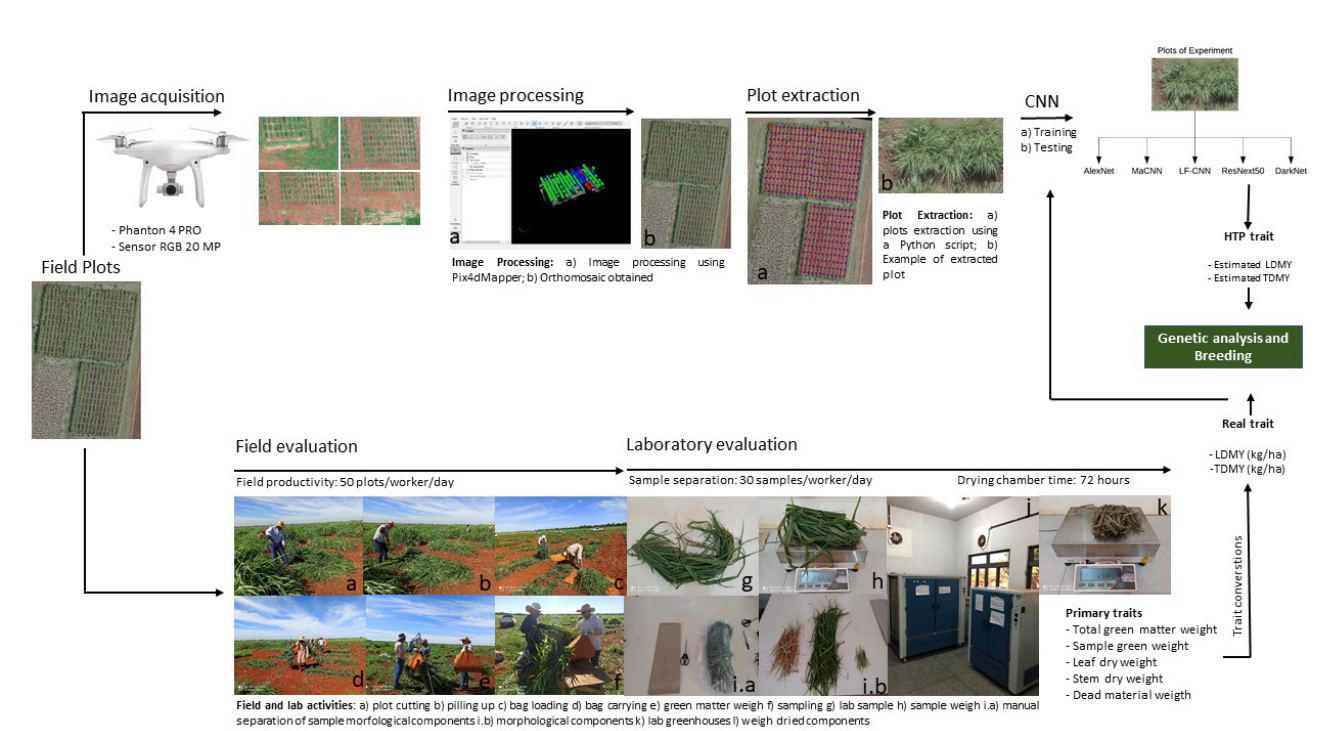
Figure 1. Workflow of phenotyping DMY traits by conventional ( bellow ) and high-throughput ( above ) processes in the guineagrass breeding program at Embrapa Beef